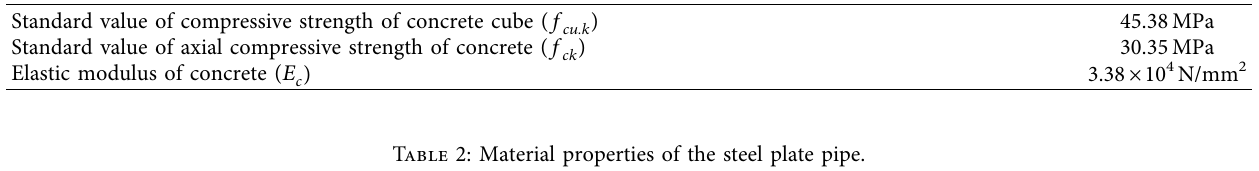
Table 1: Material properties of concrete.